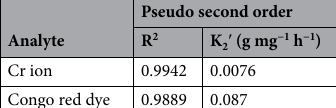
CR-dye. Table 2 lists the numerical values of the Langmuir and Freundlich adsorption constant and the regres- sion correlation coefficient. The values of K L range within 0 to 1, which demonstrates that the samples have a better absorption for Cr(VI) ions and CR-dye.